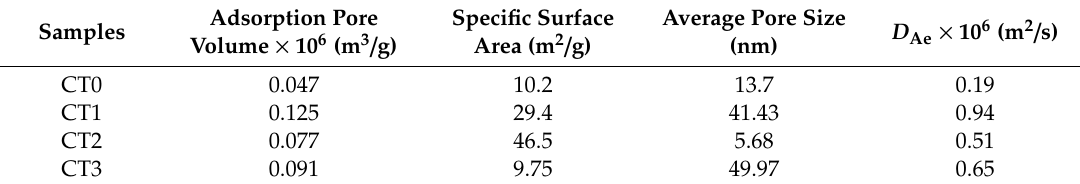
Table 1. Pore structure parameters and the e ff ective di ff usion coe ffi cient.